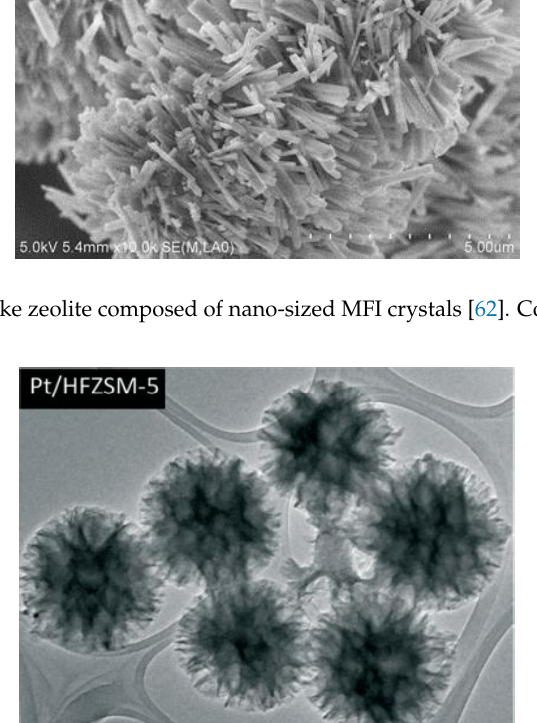
Table 3. Textural properties of hierarchical ZSM-5 zeolite in the references.